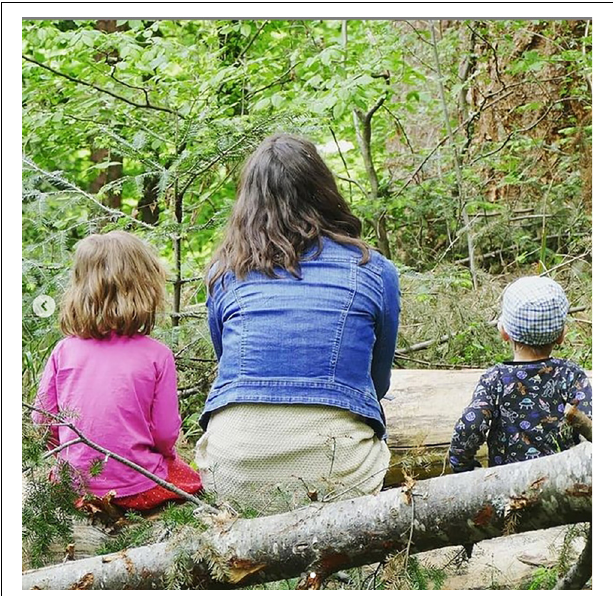
FIGURE 4 | Sitting in forest (source: Instagram/@systemisch.achtsam.artgerecht/Teresa Kotter).